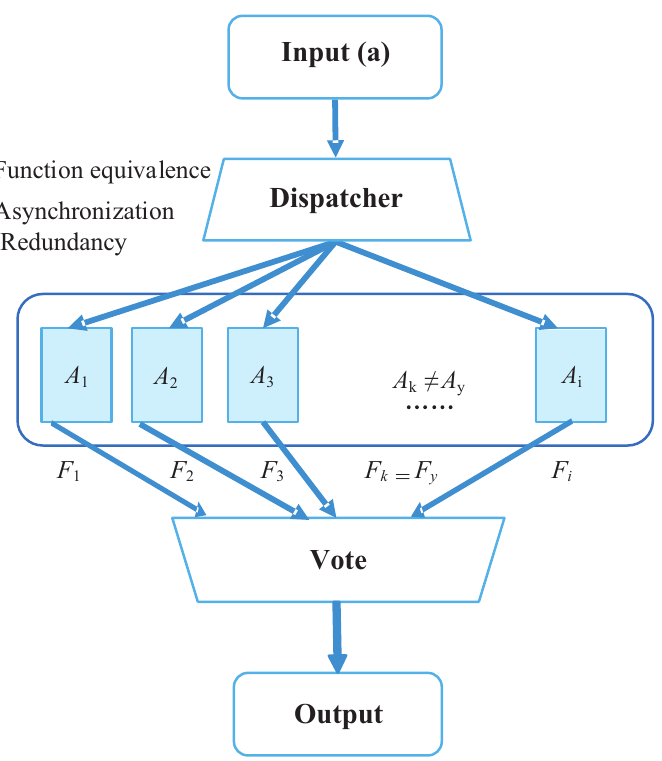
Figure 2. Relative truth logical expression